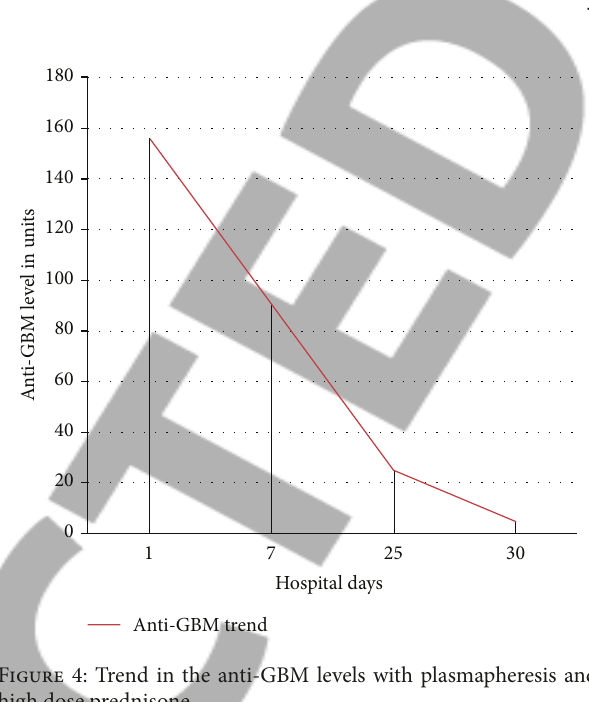
Figure 4: Trend in the anti-GBM levels with plasmapheresis and high dose